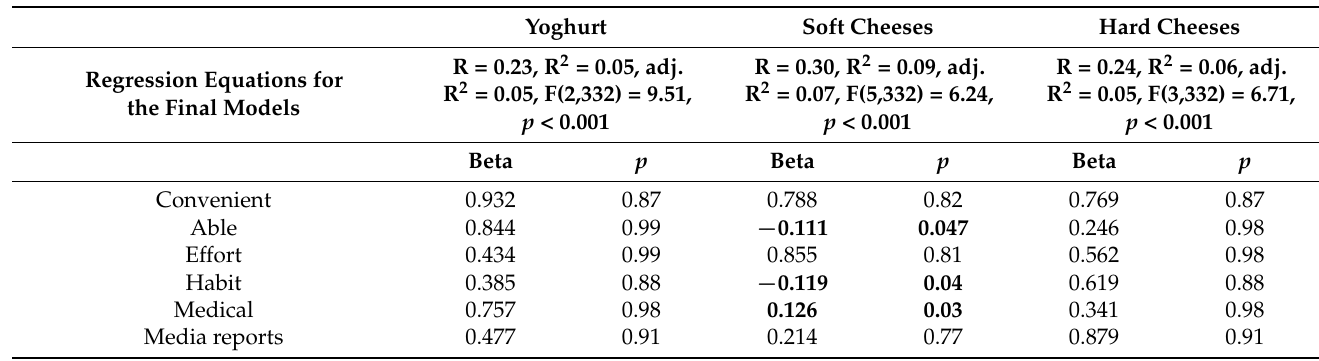
Table 2. Cont. Yoghurt Soft Cheeses Hard